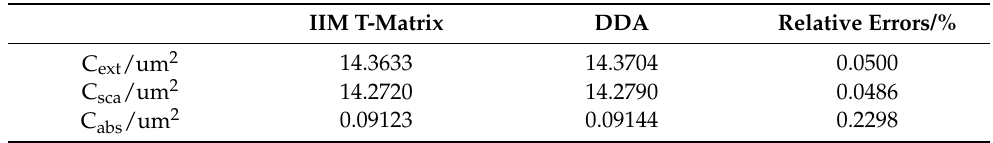
Table 3. The integral scattering properties of the octagonal prism particles calculated by IIM T-matrix and DDA methods. Table 4. The integral scattering properties of the twelve prism particles calculated by IIM T-matrix and DDA